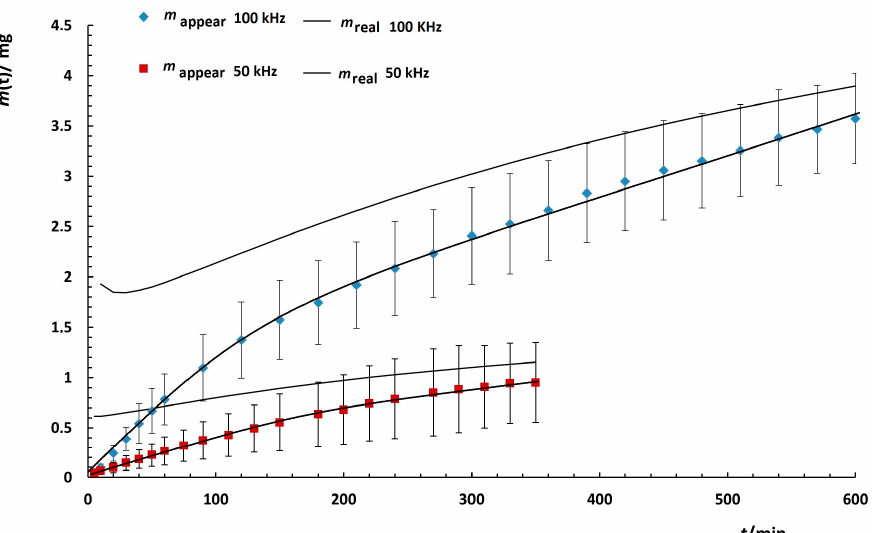
Figure 6. The cumulative apparent mass of released quercetin through 25 kDa dialysis membranes in Figure 6. ( A ) The cumulative apparent mass of released quercetin through 25 kDa dialysis mem- PBS/EtOH (Vol.% 50:50) at 37 ◦ C and calculated actual dialyzed mass of quercetin at 37 ◦ C under a branes in PBS/EtOH (Vol. % 50:50) at 37 °C and calculated actual dialyzed mass of quercetin at 37 permanent magnetic field B = 11 mT and alternating field with frequencies of 50 and 100 °C under a permanent magnetic fi eld B = 11 mT and alternating fi eld with frequencies of 50 and 100 kHz.